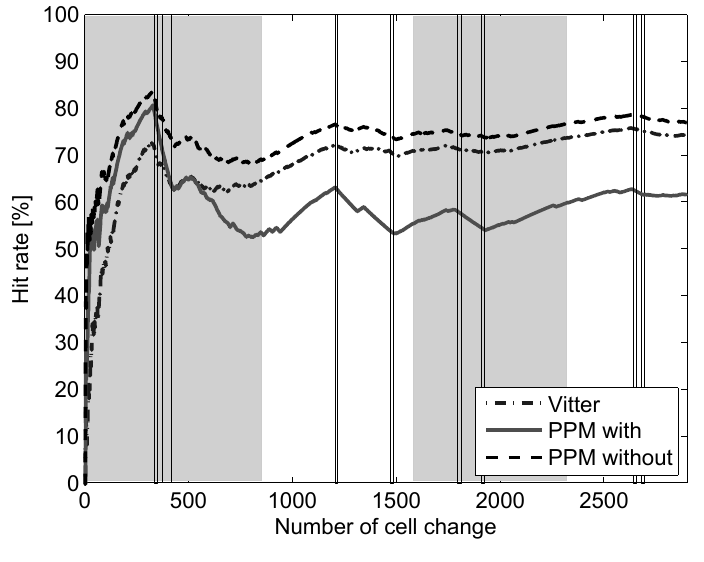
Figure 4. Hit rate evolution when processing the 4 days trace with Active LeZi updating scheme combined with each probability calculation method.